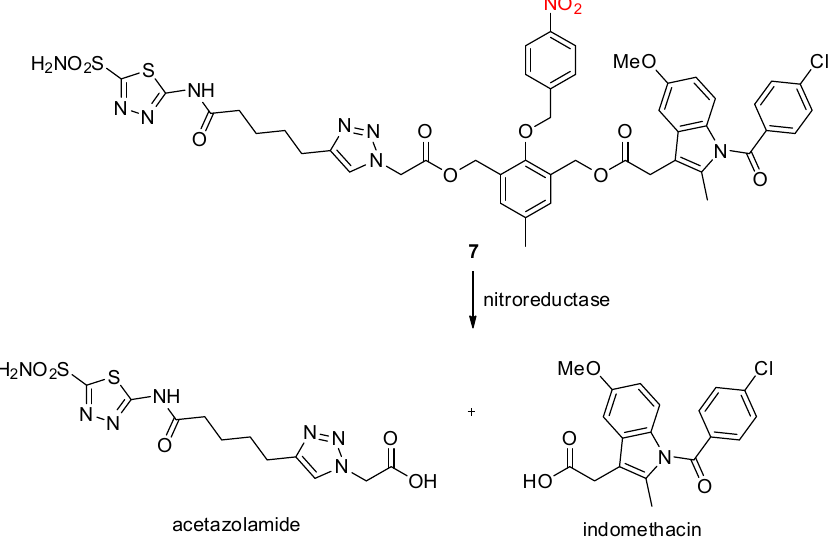
Scheme 7. Liberation of two pharmacophores, acetazolamide and indomethacin, from prodrug 7 after nitroreductase activation .